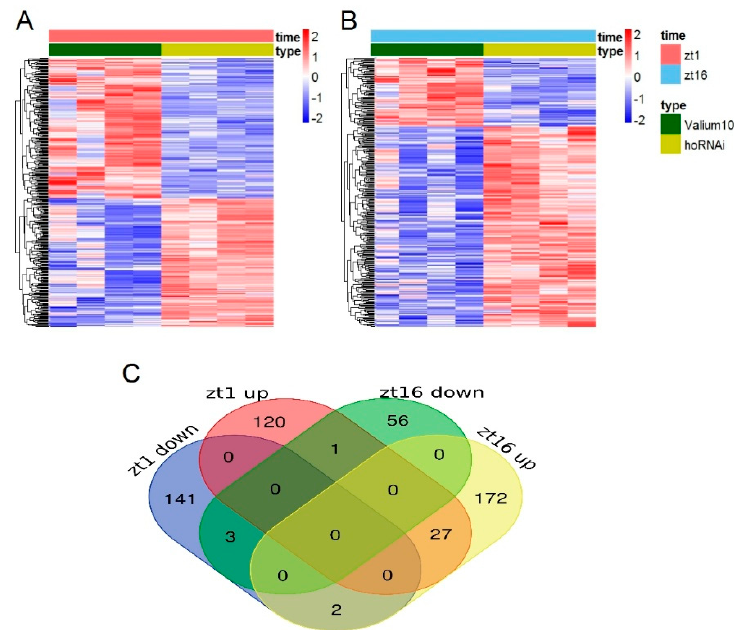
Figure 6. The differentially expressed genes (DEGs) between GMR> Valium10 control samples and GMR> hoRNAi samples with the silenced ho gene ( p -value < 0.05, fold change (FC) > 1 or FC < − 1). ( A ) a heatmap showing log2 expression values of the 348 transcripts at the beginning of the day (ZT1). Each row represents one gene transcript. Values within a row were normalized and a row mean equals 0. Rows were hierarchically clustered. The 180 transcripts were downregulated while the 168 transcripts were upregulated. This allows the conclusion that the silencing of the ho gene leads to differences in the activity of the retina cells in the presence of light during the day; ( B ) a heatmap showing log2 expression values of the 304 transcripts in the middle of the night (ZT16). The details of the data preparation and presentation are the same as in ( A ). The 77 transcripts were downregulated while the 227 transcripts were upregulated. The analysis showed that silencing of the ho gene also caused changes in the retina cell activity in the absence of light during the night. The Venn diagram ( C ), which visualizes the numbers of common members of both group transcripts, clearly shows that the majority of genes responding to the ho gene silencing at ZT1 were not receptive at ZT16 (and vice versa). The Venn diagram takes into consideration only transcripts, which were successfully annotated (298 out of 348 in case of A and 263 out of 304 in case of B ).